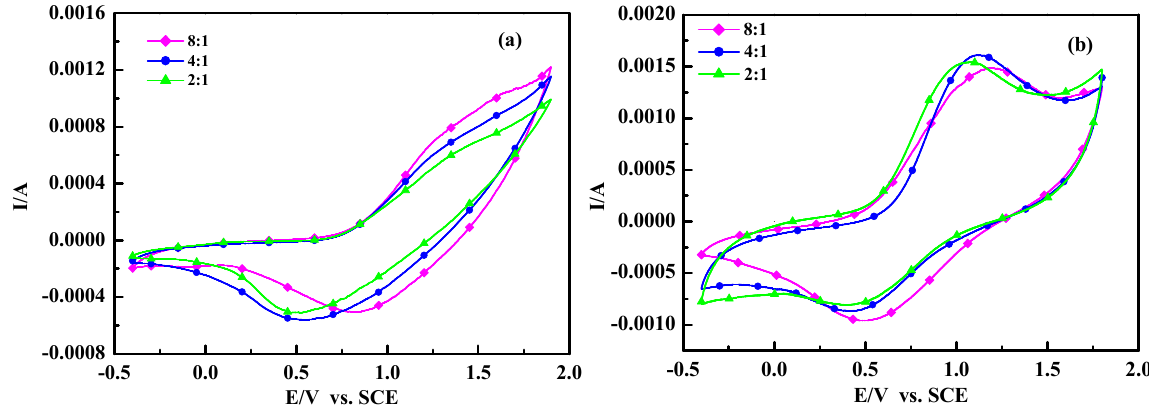
Figure 6. Cyclic voltammograms of polymers: ( a ) poly(TT)s; ( b )